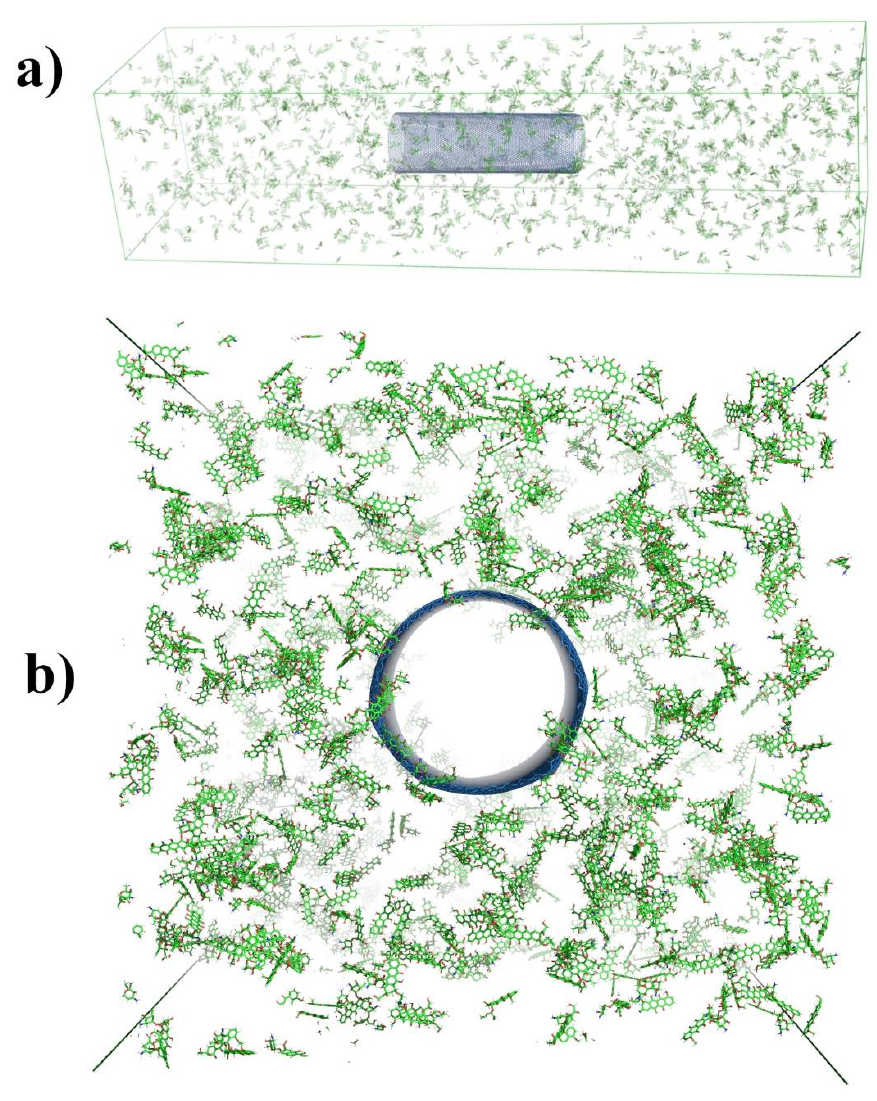
Figure 5. Snapshots of the input configuration from two points of view: ( a ) three-dimensional perspective; ( b ) view along the y-direction—we can see that initially the carbon nanotube was